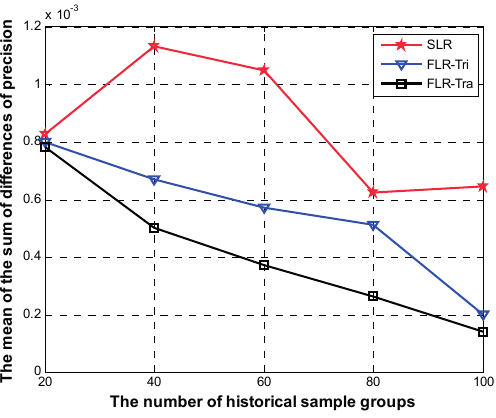
Figure 8. The mean of the sum of difference of evaluation precision R(cid:3365)